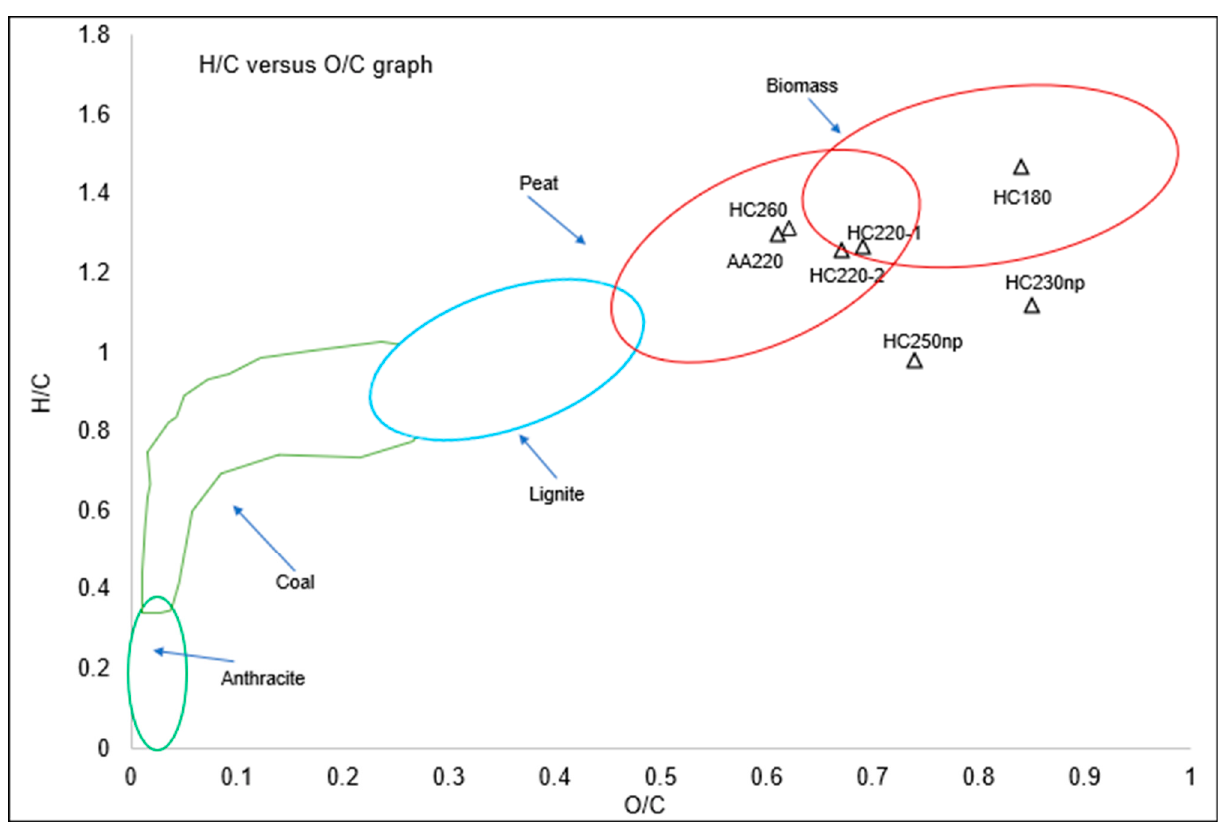
decarboxylation, which reduce H/C and O/C ratios. Similar behavior was observed with the tomato plant, where the H/C and O/C ratios reduced after HTC, although the uncarbonized biomass oxygen content was higher compared to other biomass feedstocks. Results also revealed substantial increase of C from about 37 to 49%, and reduction of O from about 54 to 47% with hydrothermal treatment. Similar results were observed at